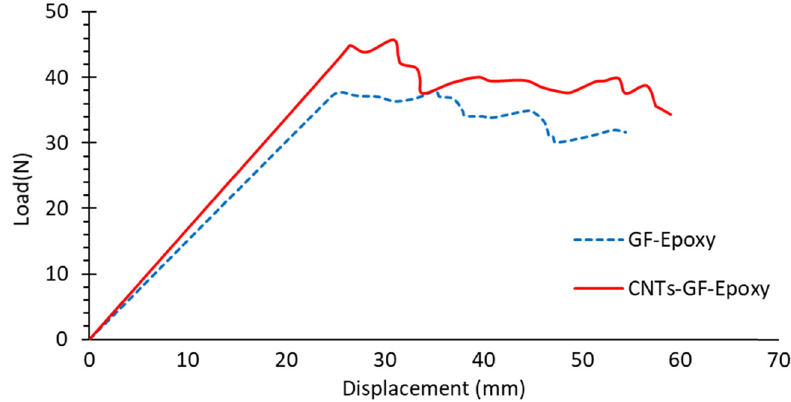
Figure 7: Load versus displacement curves for control sample ( GF - Epoxy ) and hybrid sample ( CNTs - GF - Epoxy ) .